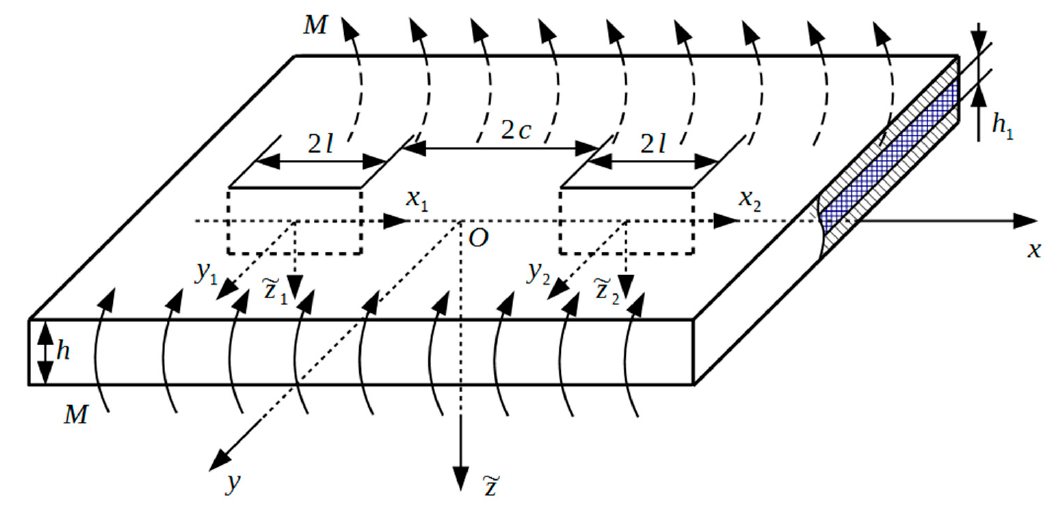
Figure 1. Plate geometries and load scheme.